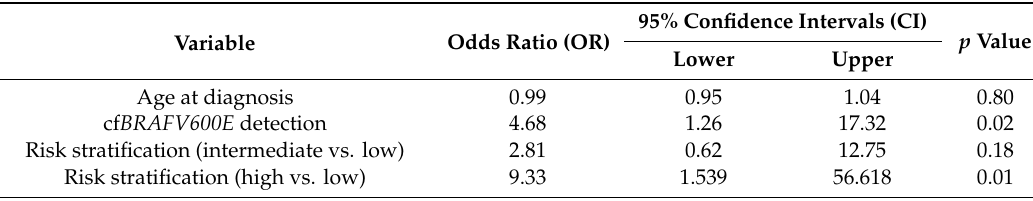
OR, odds ratio; CI, confidence